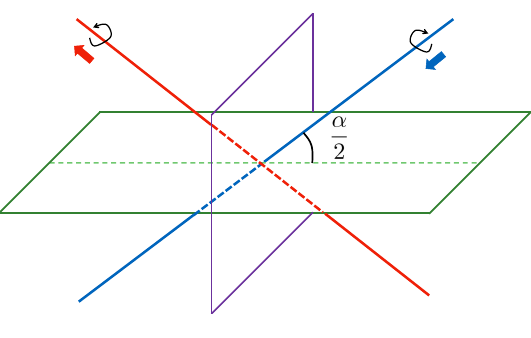
Figure 7 . Two strings (red and blue lines) collide with the crossing angle α . The black arrows indicate the directions of the topological winding number of U(1) PQ . The red and blue arrows indicate the directions of the flowing electric currents, which are parallel for α = 0 . The green and purple planes are orthogonal and include the collision